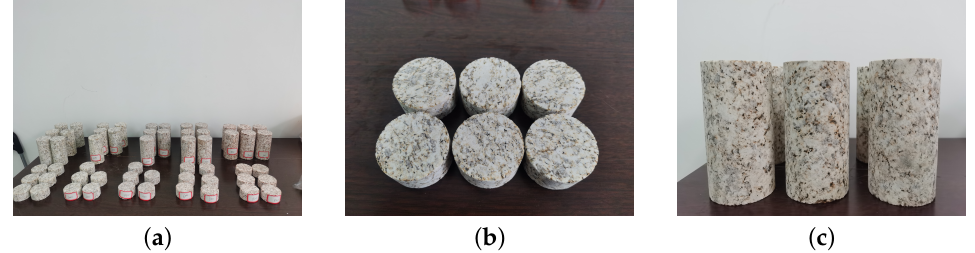
Figure 1. Beishan granite specimens. ( a ) Beishan granite specimens; ( b ) ϕ 50 mm × 25 mm; ( c ) ϕ 50 mm × 100 mm.